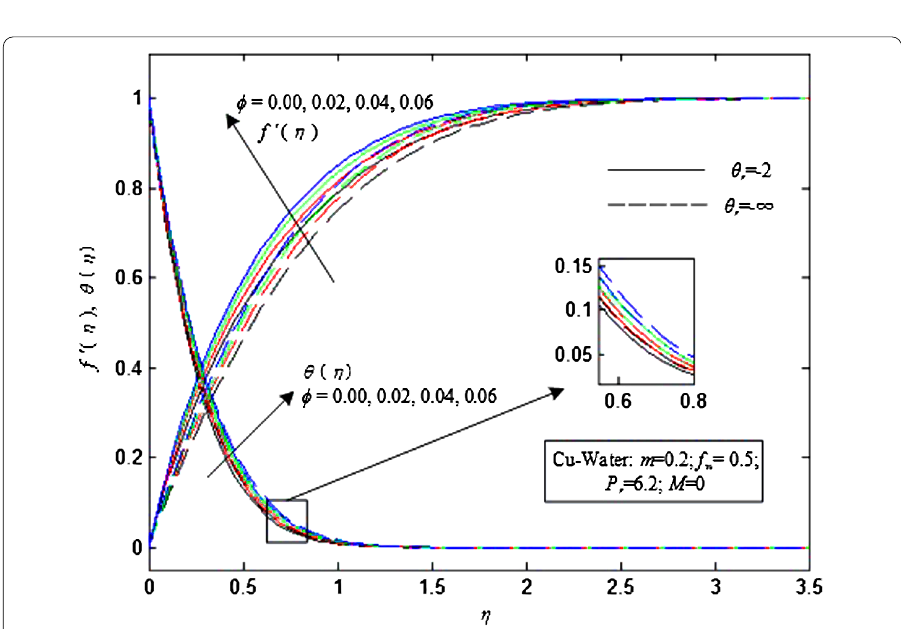
Figure 7 Velocity and temperature profiles of Cu-Water nanofluid for representative values of φ with different θ r